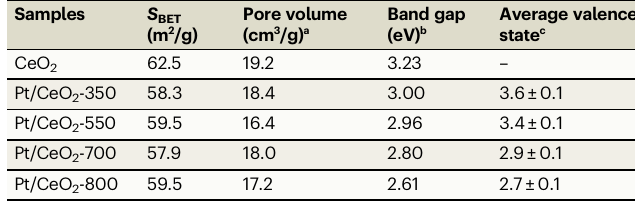
Table 1 | Textural properties determined by N 2 physisorption results, band gap determined by UV – Vis spectra, and the average valence states of Pt species determined by XANES linear combination fi tting